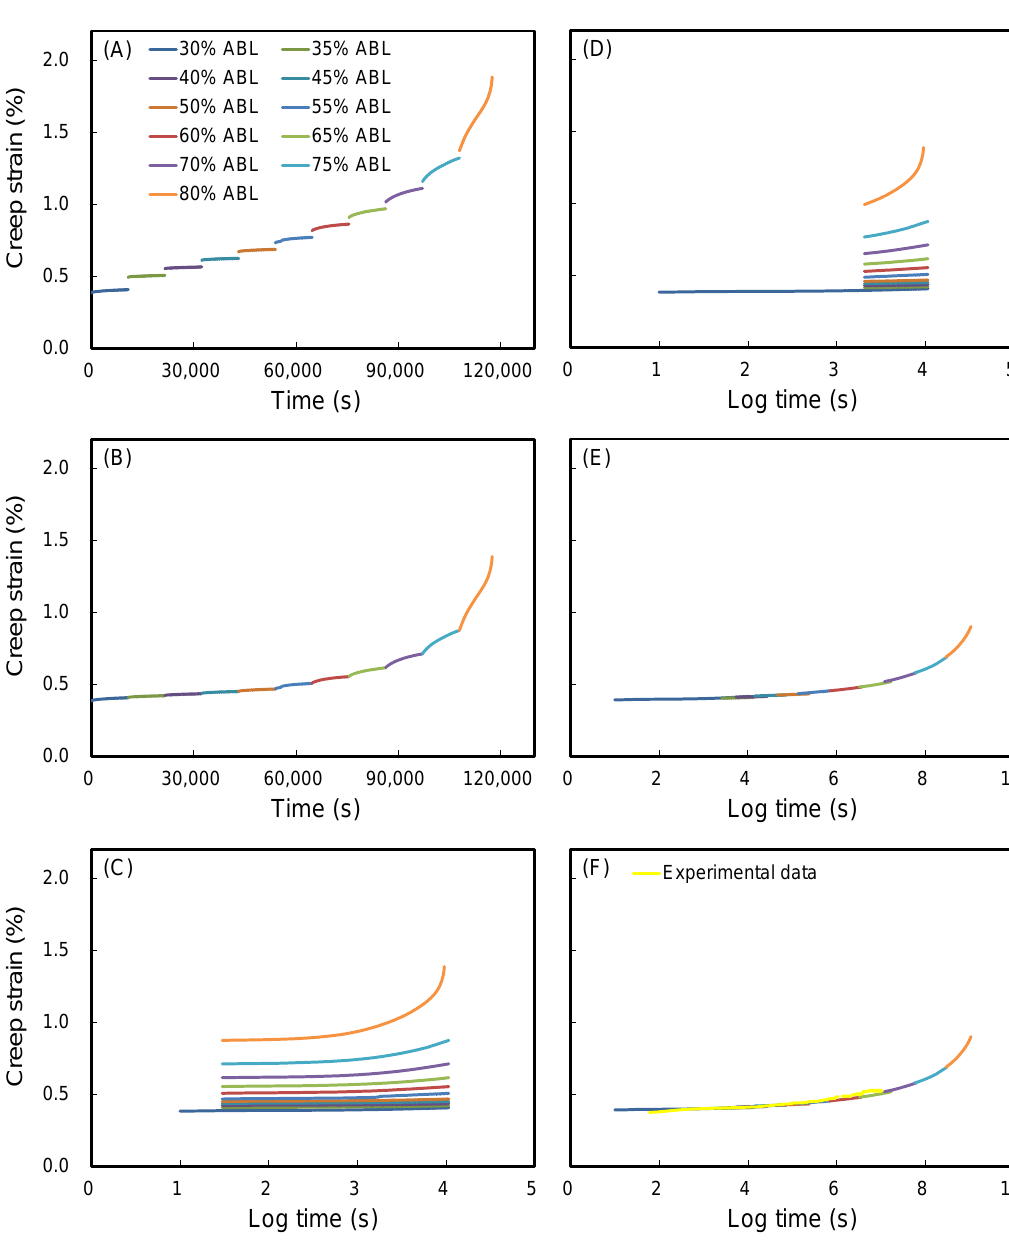
Figure 1. ( A ) The SSM creep data of the WIC MTEOS (reference stress: 30% ABL; interval stress: 5% ABL; dwelling time: 3 h). The handing of the SSM test data for WIC MTEOS : ( B ) vertical shifting, ( C ) rescaled creep curves, ( D ) eliminating the period before the onset time of each stress step, and ( E ) horizontal shifting. ( F ) Experimental data and master curve.